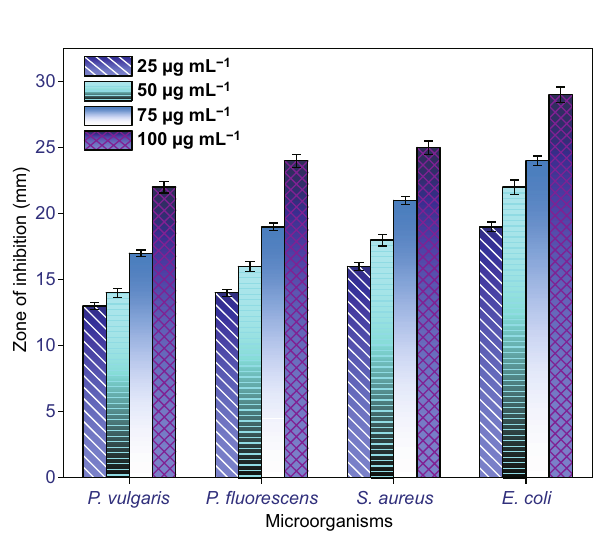
Fig. 4 Comparison of antibacterial activity of eugenol-assisted CuO nanoflowers against Pseudomonas fluorescens , E . coli , and S. aureus using well agar diffusion process. (Color figure